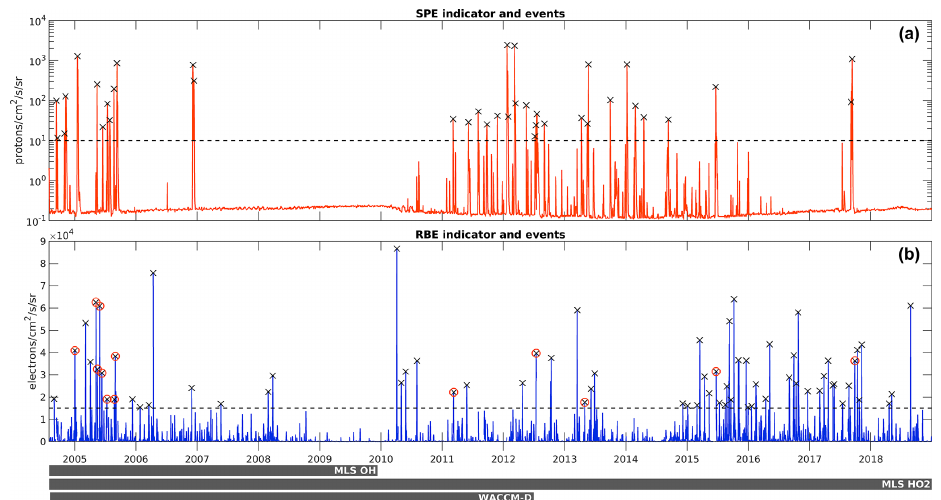
Figure 3. SPE indicator (a) and RBE indicator (b) . Used precipitation limits for events are shown as dashed lines, and precipitation events are indicated by crosses. Encircled crosses mark RBE events with an SPE event in the same month. Availability of MLS OH and HO 2 and WACCM-D data used in the analysis is also shown below the graphs.